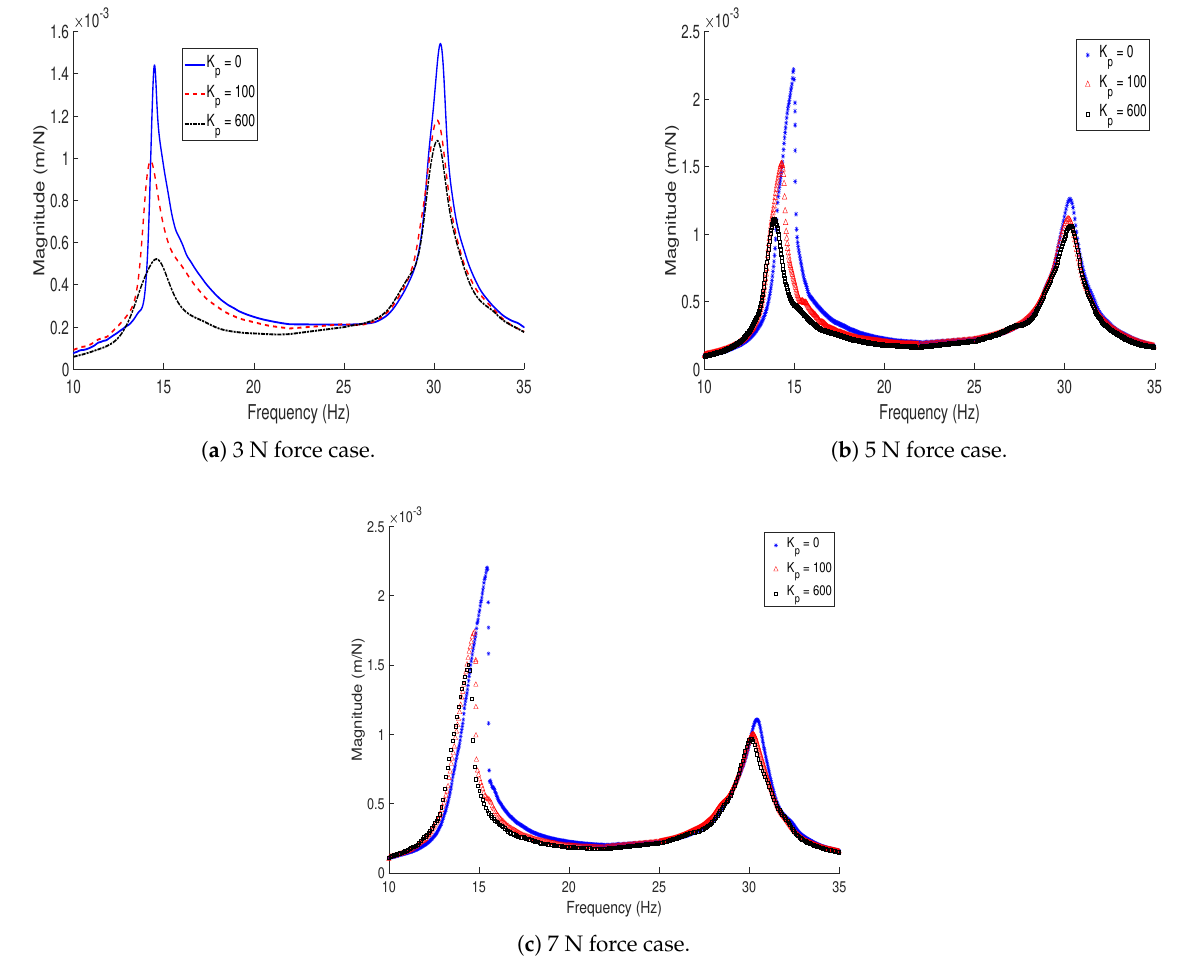
Figure 8. The response of the structure where the base excitation was swept upwards through the first and second resonance frequencies at a force level of ( a ) 3 N of force, ( b ) 5 N of force, and ( c ) 7 N of force for three magnitudes of control